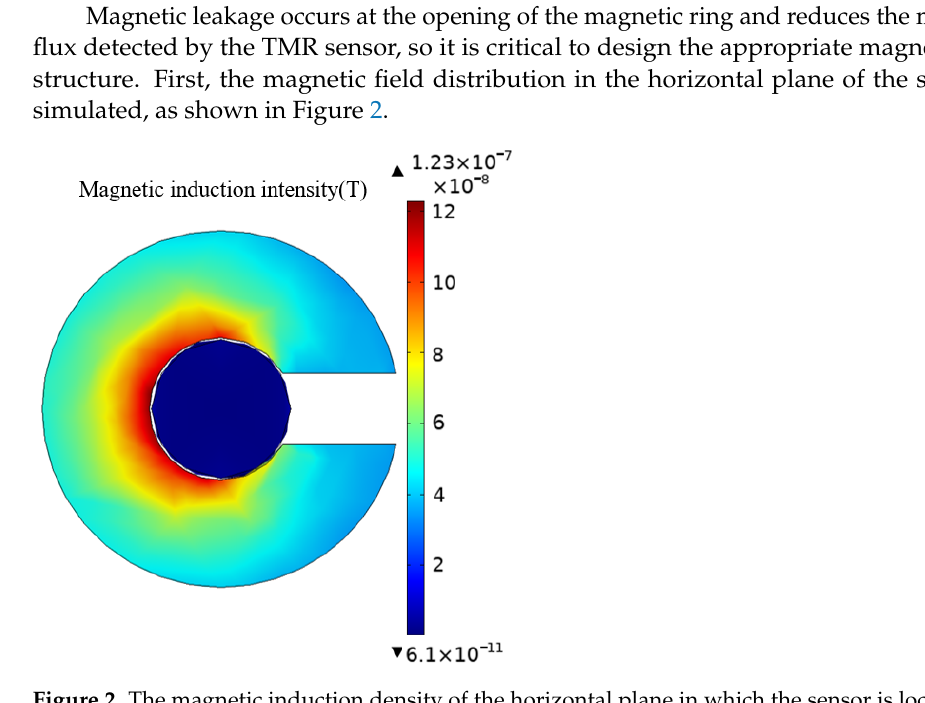
Figure 2. The magnetic induction density of the horizontal plane in which the sensor is